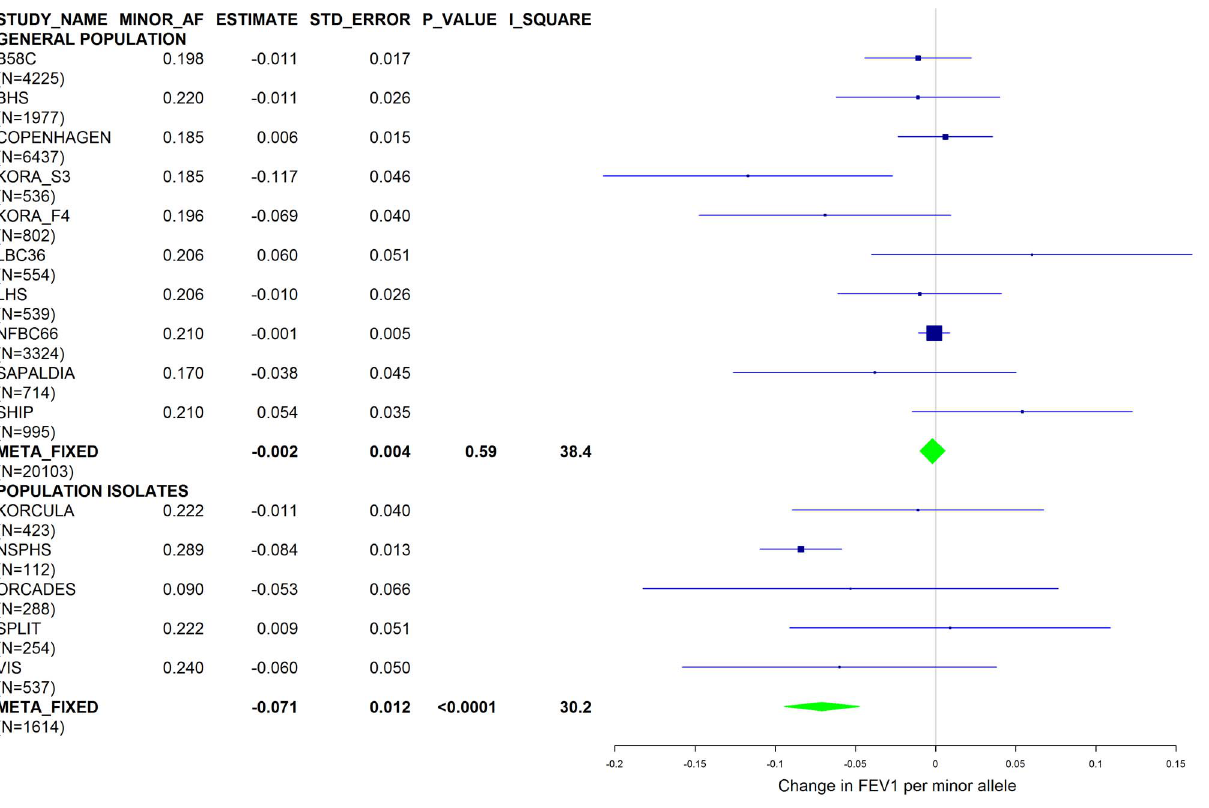
Figure 6. Forest plot of meta-analyzed results for the effect per minor allele of rs4905179 on FEV1 in ever-smokers, adjusted for sex, age, height, population stratification factors and the presence of PI S and Z alleles. Studies based on population isolates with a high degree of cryptic relatedness are presented separately. Effect estimates of meta-analyses are shown with green diamonds. I 2 is a measure of the heterogeneity between studies. Random effect meta-analyses are included if I 2 . 0.5. Study weights (blue squares) correspond to fixed effect meta- analyses.